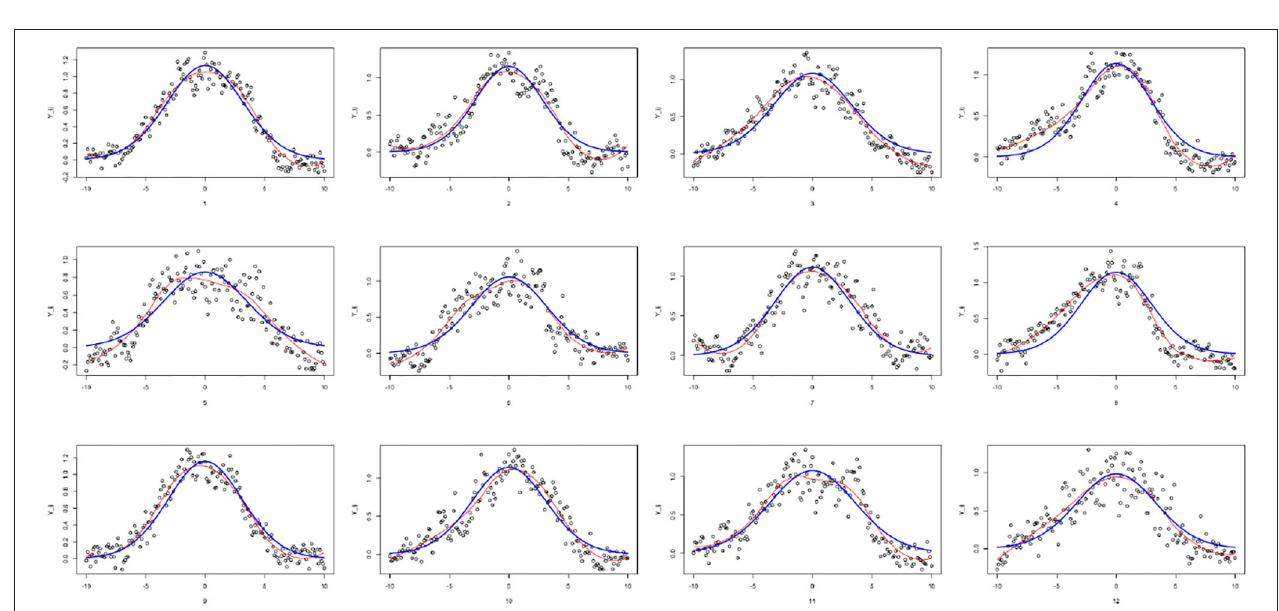
FIGURE 7 | Individually fitted curves for each tube: loess-smoothed curves (in red), IDE solution R λ , µ (in